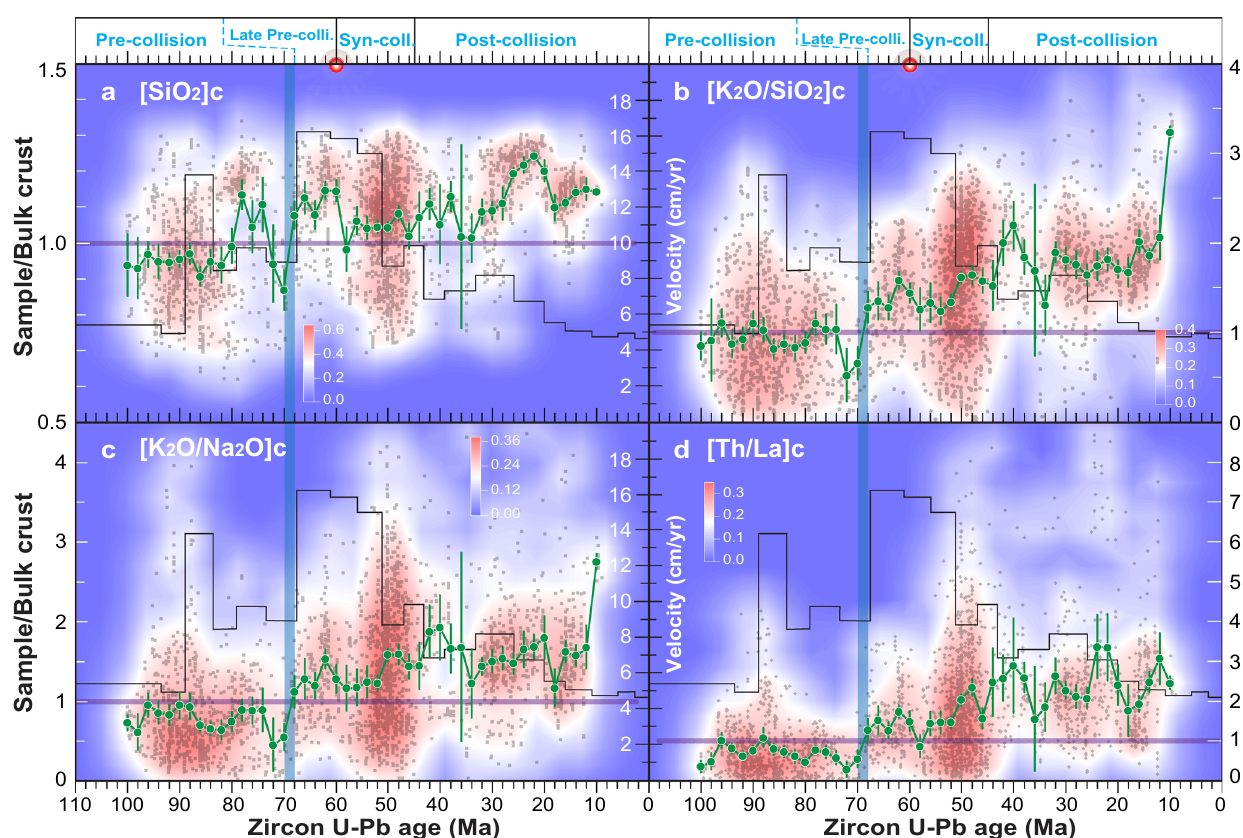
Fig. 3 | Evolving compositionofmagmaticrocks from theGangdeseBatholith. a – d Gray dots show composition of individual samples and larger green dots with green vertical lines are averagecompositions and 2s.e. uncertainties of samples in 2Myr bins (obtained using the Monte Carlo analysis with weighted bootstrap resampling) 37 normalized by bulk continental crust. Values of bulk 38 are shown by purple horizontal lines. The India-Asia convergence velocity since 110Ma (black line) is from ref. 13 and is shown for comparison with the changes in magmatic